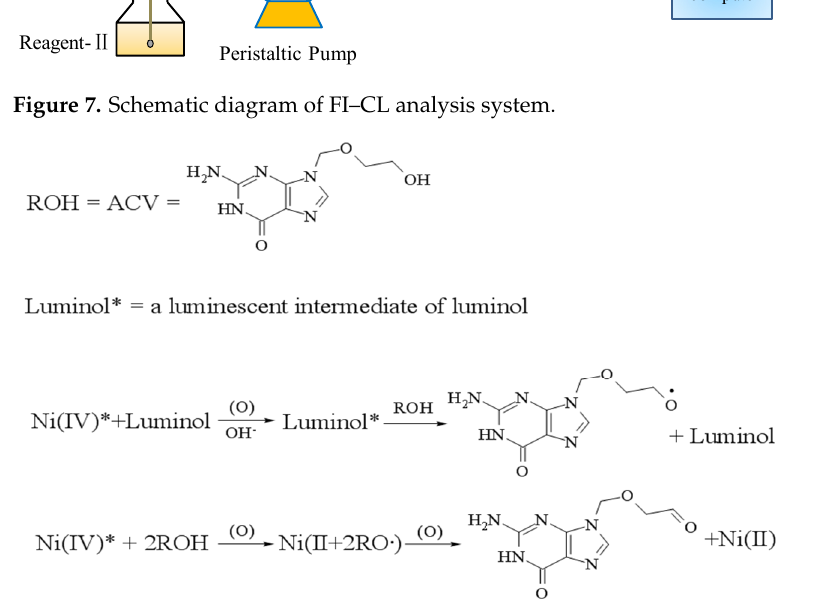
Figure 8. Chemistry mechanism for the ACV detection in Reference [103]